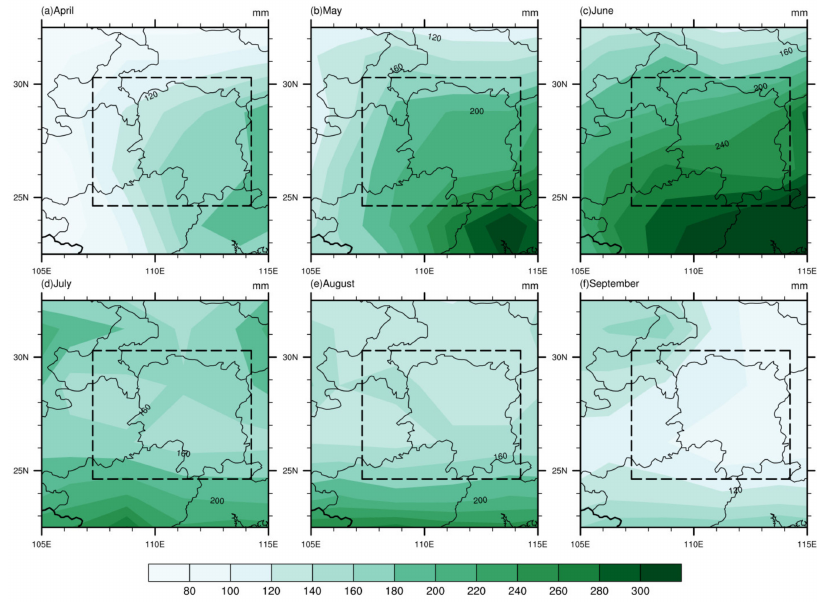
Figure 2. Monthly precipitation during the flood season from 2006 to 2019, unit: mm. Table 3. The precipitation grading standards monthly and seasonally: ( (cid:52) R% is the percentage of precipitation